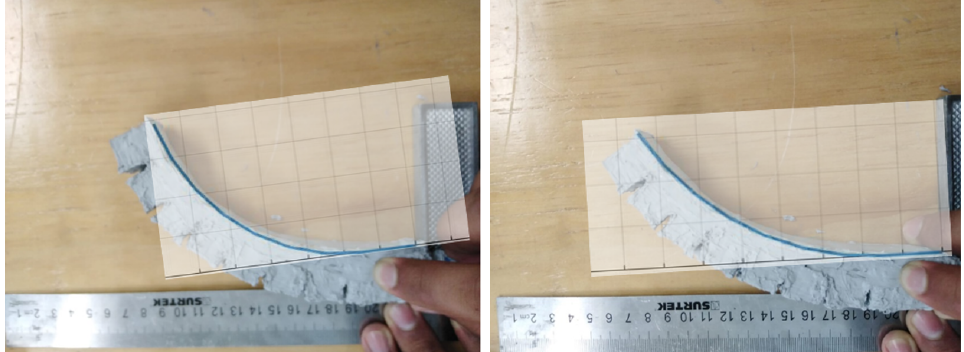
Figure 15. Comparison between Modeled Displacement and Test Measurements of soft actuator flexion at different pressures. ( left ) Comparison at 1.5 kg/cm 2 . ( right ) Comparison at 2 kg/cm 2 .